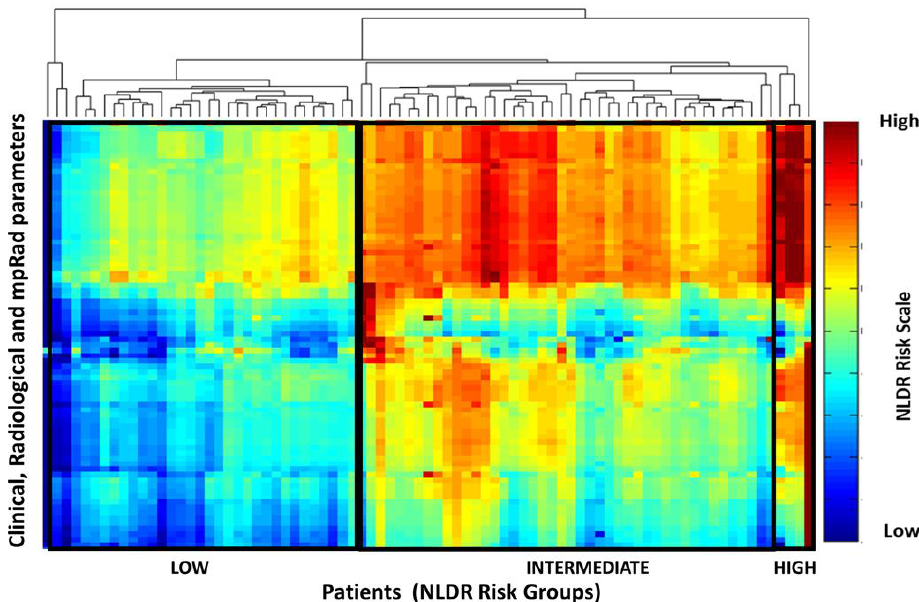
Figure 5. The IRIS heat map demonstrates the stratification of the integrated mpRad, radiological, and clinical parameters into OncotypeDX score recurrence risk groups of low, intermediate, and high. Interesting there appears to be intermediate and high-risk factors perceived in the low risk group that may not habeen noted in clinical evaluations. Similarly, there are a mix of low and high-risk features in the intermediate group. Integrated Radiomic Informatic System (IRIS), Non-linear dimension reduction (NLDR).